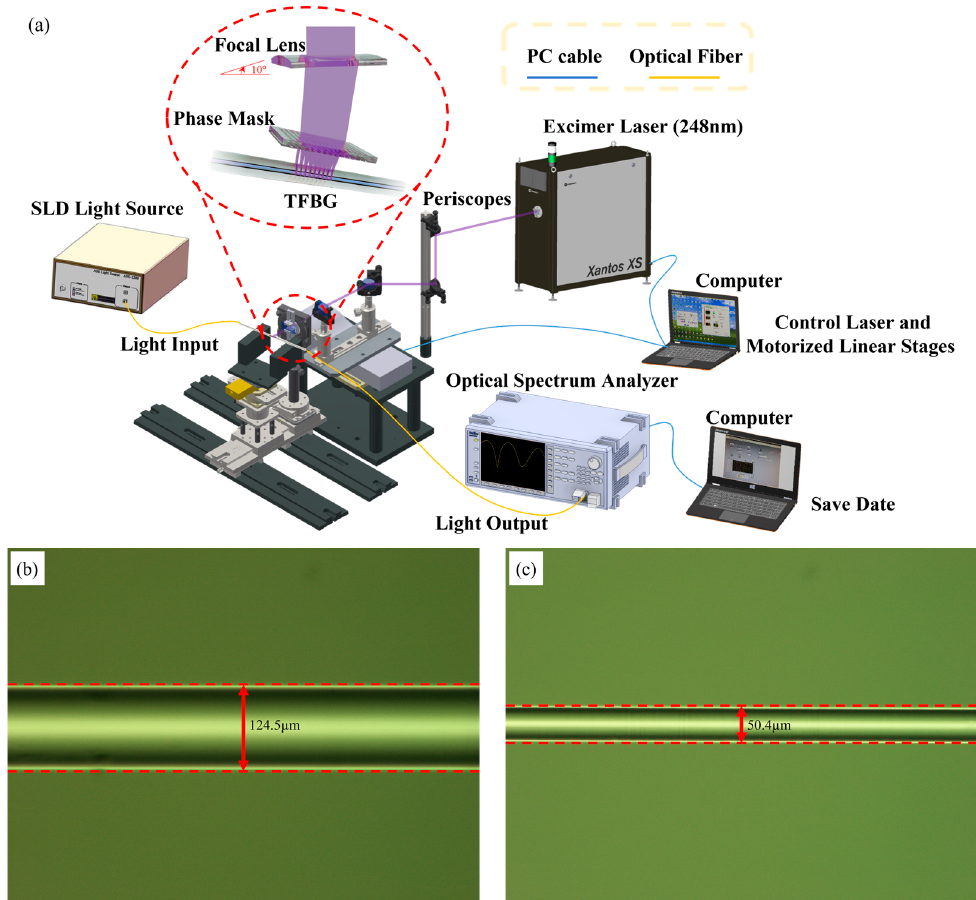
Figure 2. ( a ) Experimental setup for TFBG fabrication; ( b ) Optical microscope image of the unetched TFBG sensor; ( c ) Optical microscope image of the etched TFBG sensor.